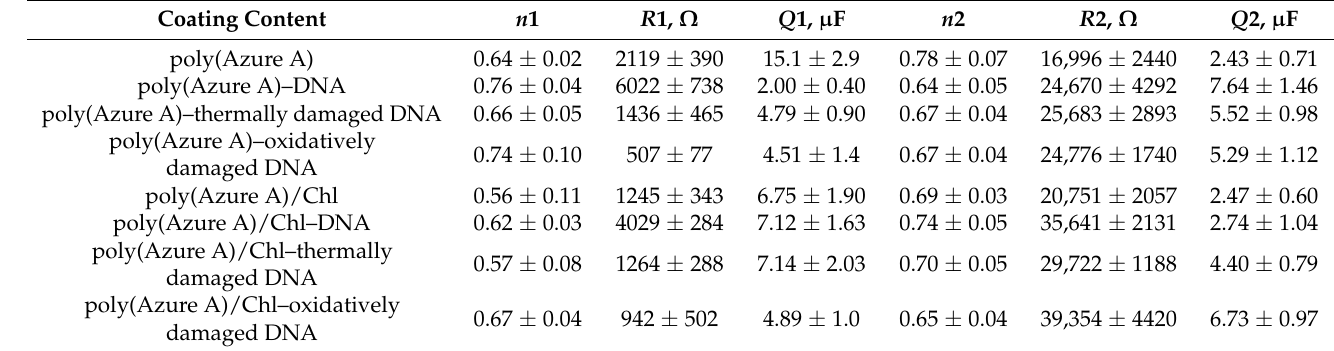
Table 1. EIS parameters obtained for poly(Azure A)–DNA assembling in various conditions of DNA treatment (average ± S.D. for six electrodes).